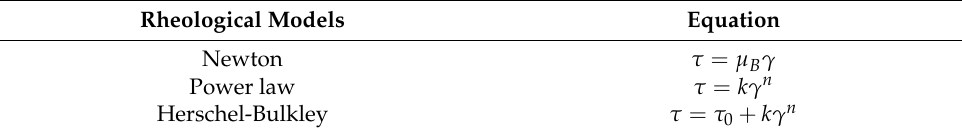
Table 1. Common fluid rheological models.